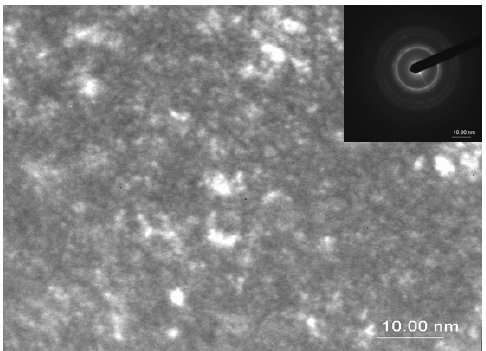
Figure 3. TEM image and corresponding EDP for the sample annealed at 500 °C.